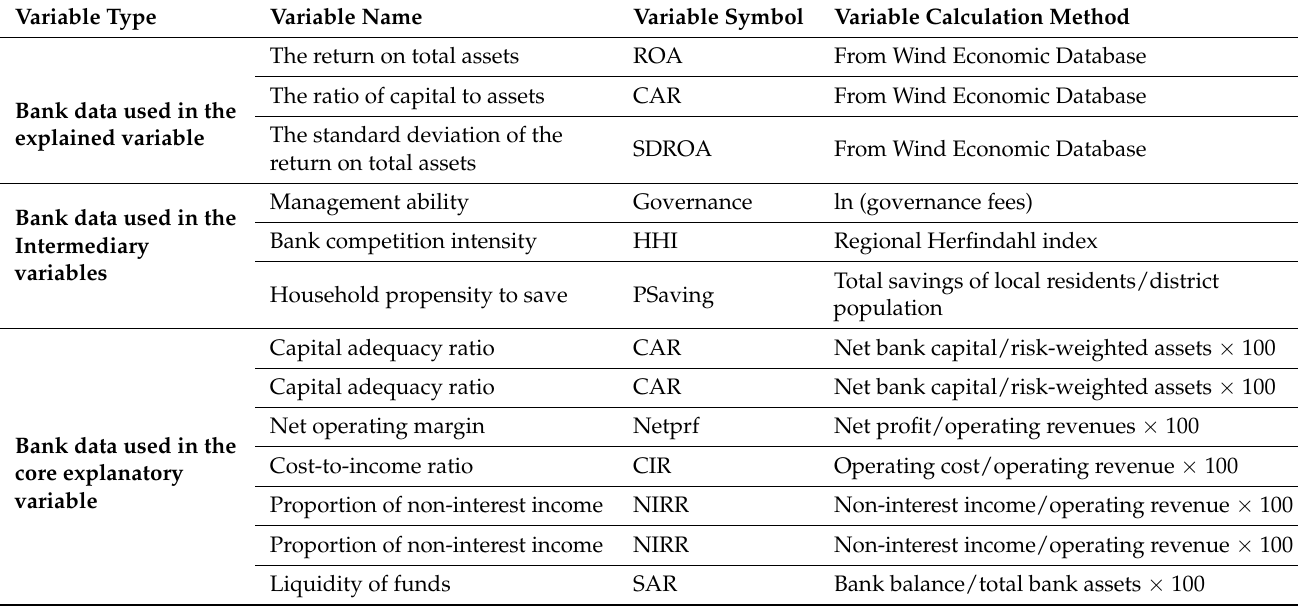
Table A1. Data used at the bank level from 2011 to